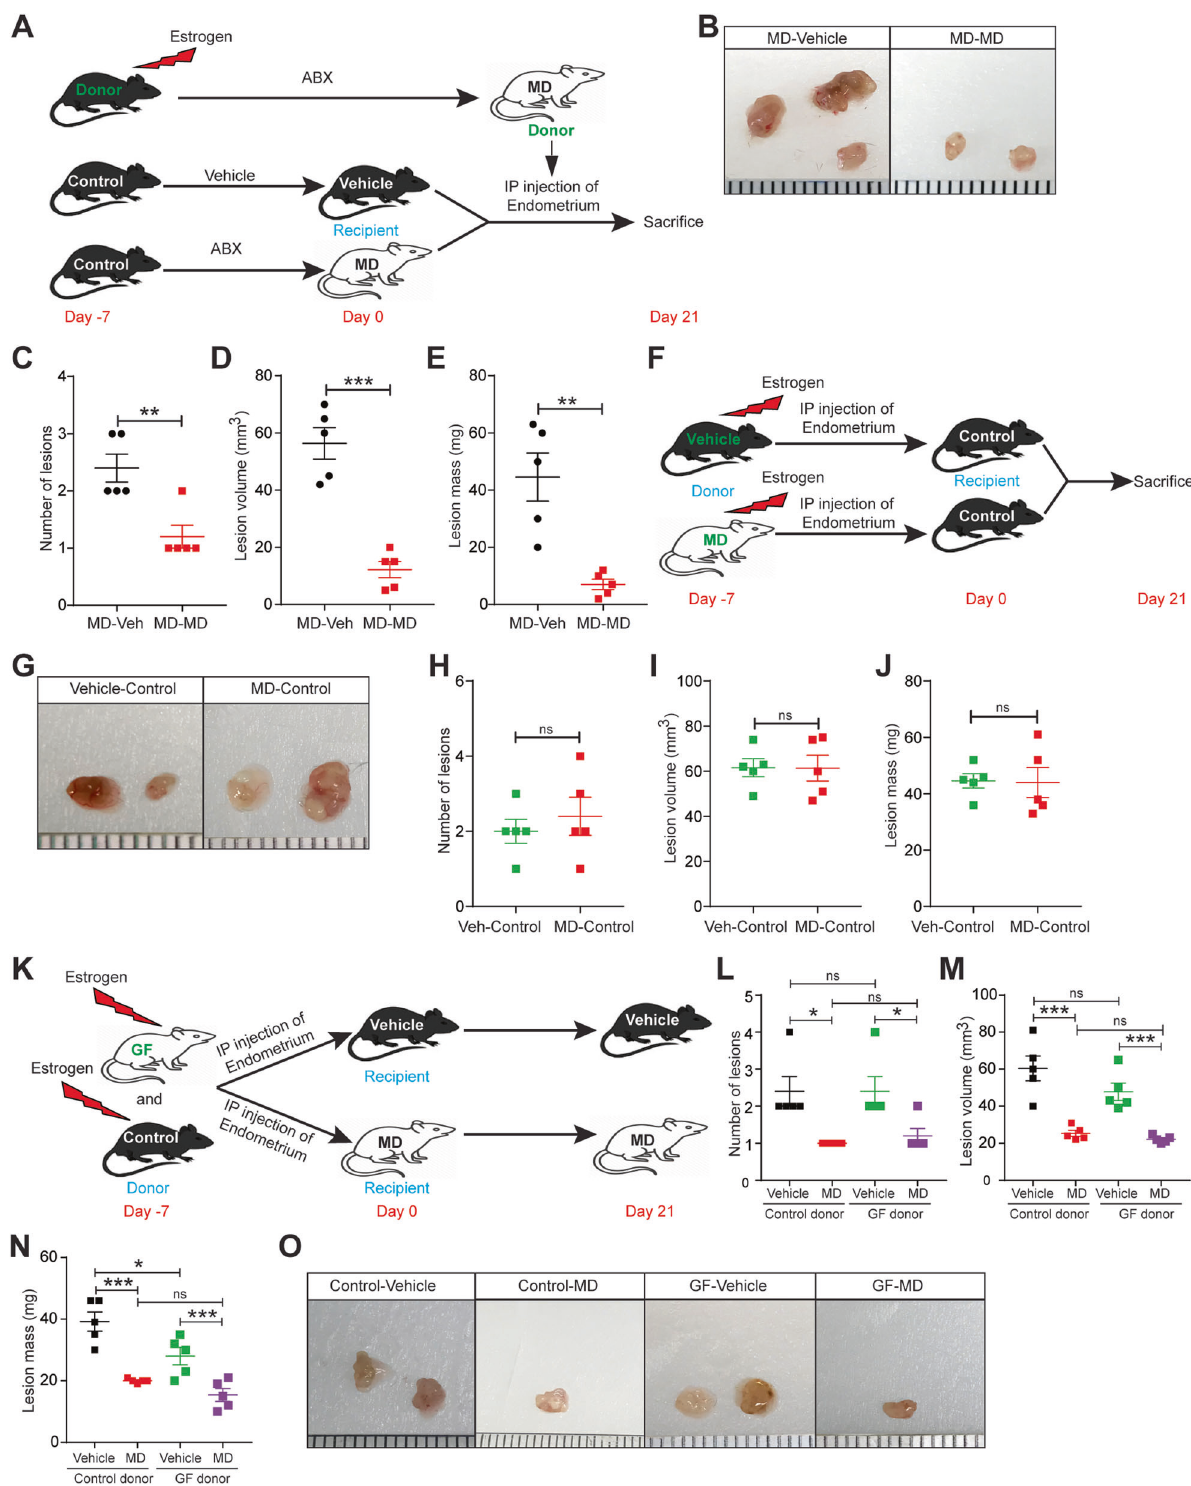
Fig. 4 Uterine microbiota might be dispensable for endometriotic lesion growth in mice. A , F , K Schematic of experimental timeline and procedures. Ectopic endometriotic lesion B , G , O representative images, C , H , L number of lesions per mouse, D , I , M volumes and E , J , N masses from the indicated groups 21 days after induction of endometriosis. Data are presented as mean ± SE ( n = 5), * P < 0.05, ** P < 0.01, *** P < 0.001 and ns nonsigni fi